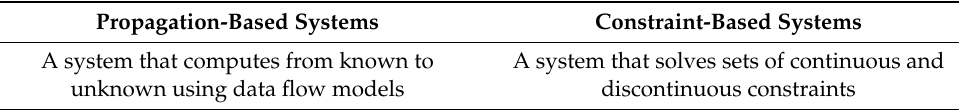
Table 2. Parametric modeling for architectural design. Propagation-Based Systems A system that computes from known to unknown using data flow